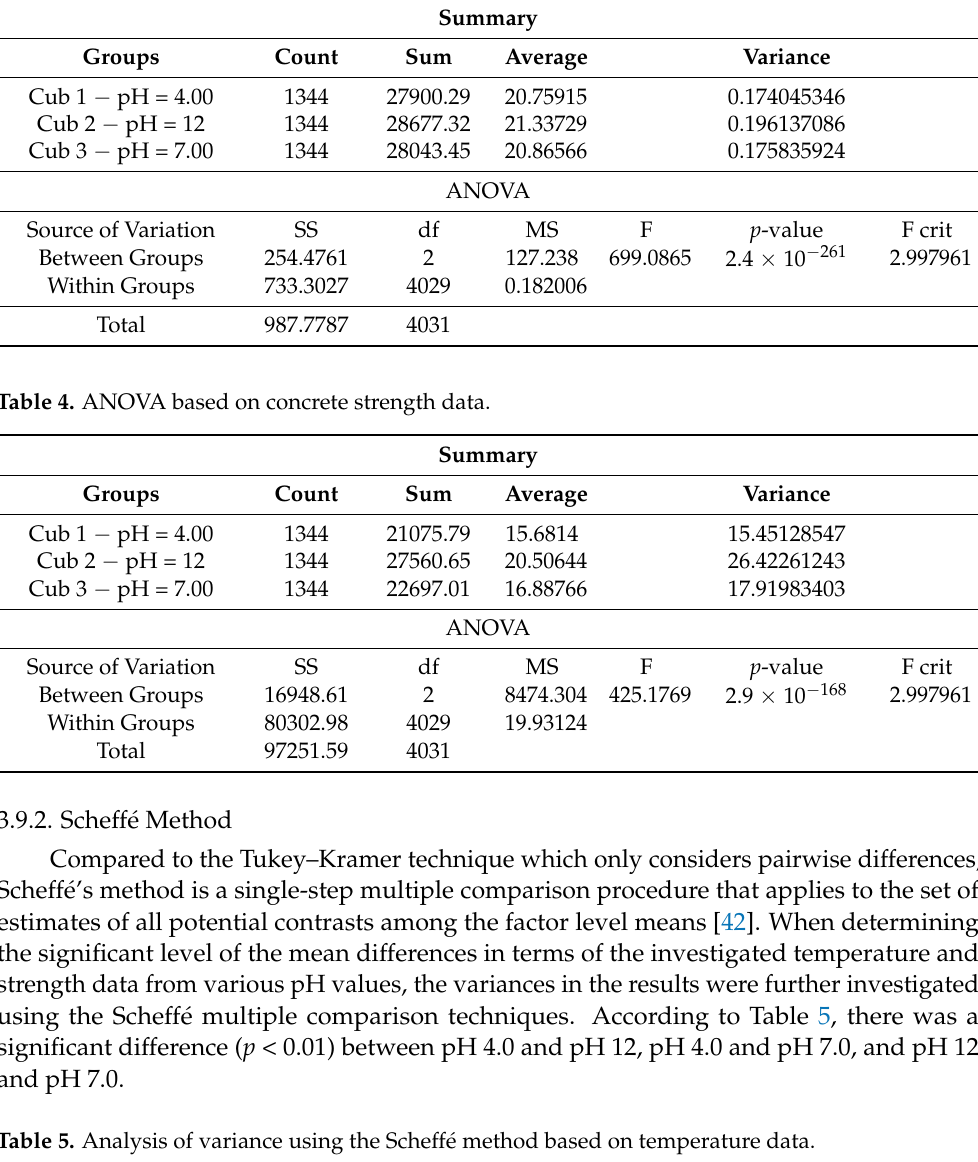
Table 3. ANOVA results based on temperature.